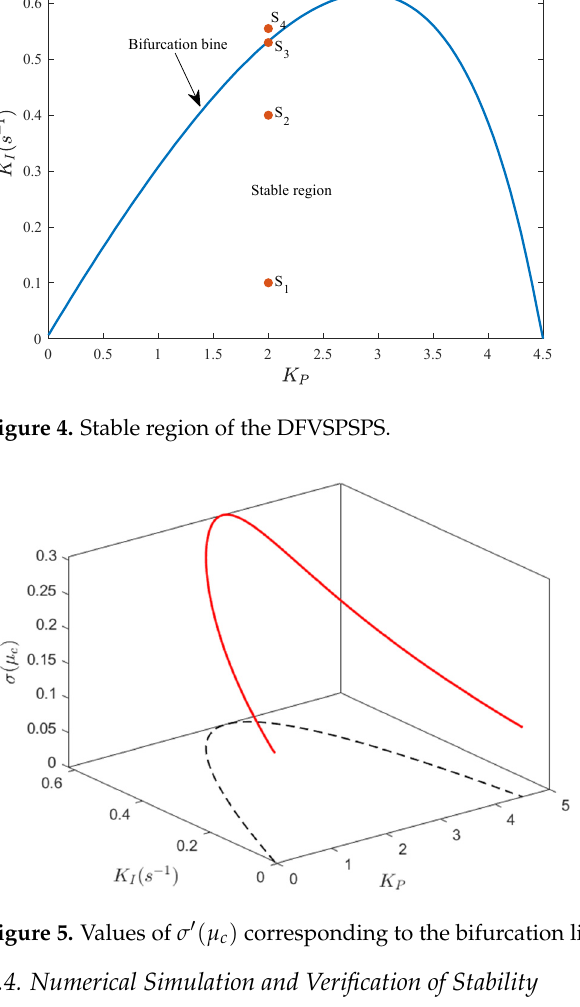
Figure 5. Values of ( )